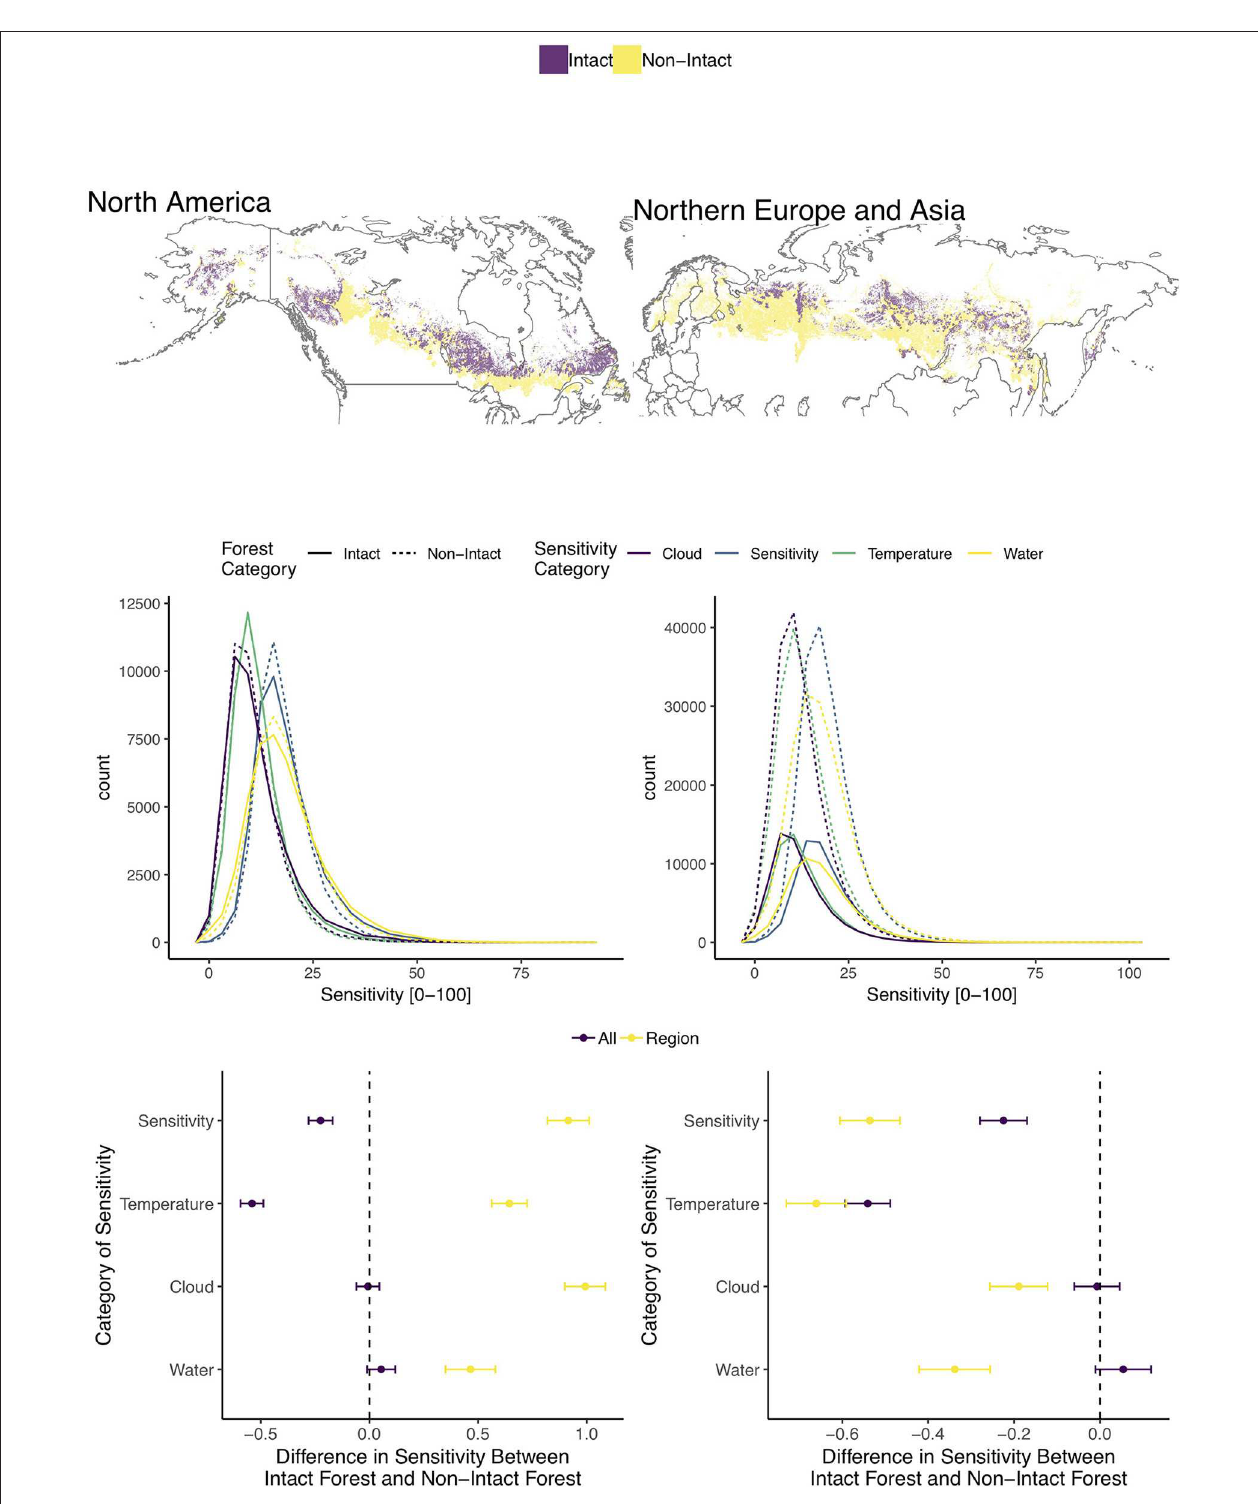
FIGURE 2 | (Top row) Distribution of intact and non-intact pixels for each analyzed continent across the boreal biome. (Middle row) Histograms of four climate sensitivity metrics for intact (solid) and non-intact (dashed) forests for each continent. (Bottom row) TukeyHSD values, with confidence intervals, comparing climate sensitivity of intact and non-intact forests for each climate sensitivity metric for all (“All”) forest pixels across the tropics and for each continent (“Region”). Negative values indicate intact forest pixels exhibited lower sensitivity for each variable and positive values indicate non-intact forest pixels exhibited lower sensitivity.